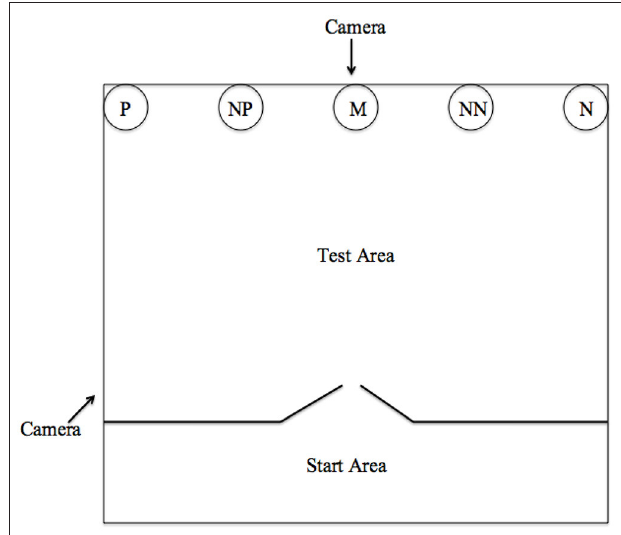
FIGURE 1 | Experimental set up for the judgement bias test with positive (P), near positive (NP), middle (M), near negative (NN), and negative (N) locations. The figure shows the locations for an individual trained to expect a positive reward in the left corner and to avoid the right. Only one bowl was present in one location at a